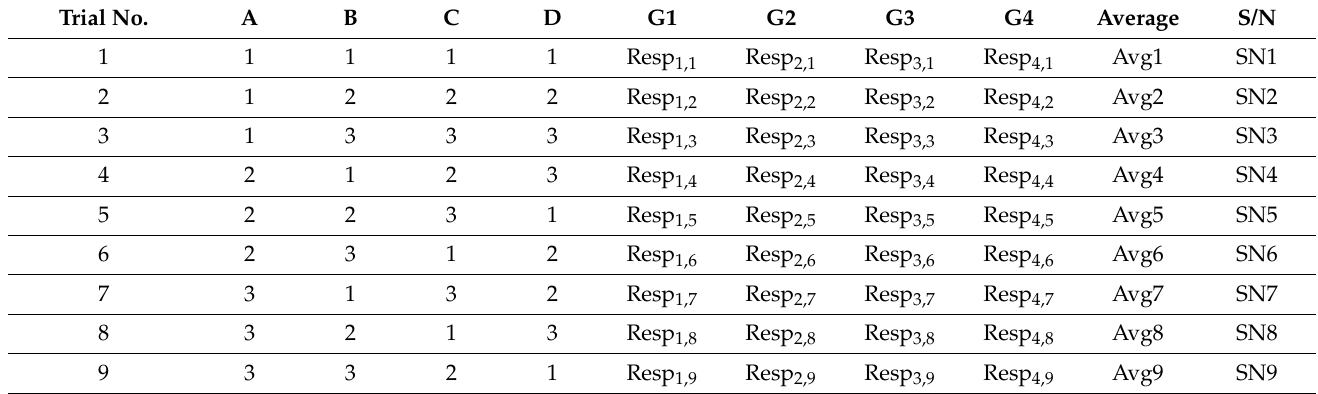
(cid:0) (cid:1) (cid:0) (cid:1) 3 4 and L 4 3 2 configurations.